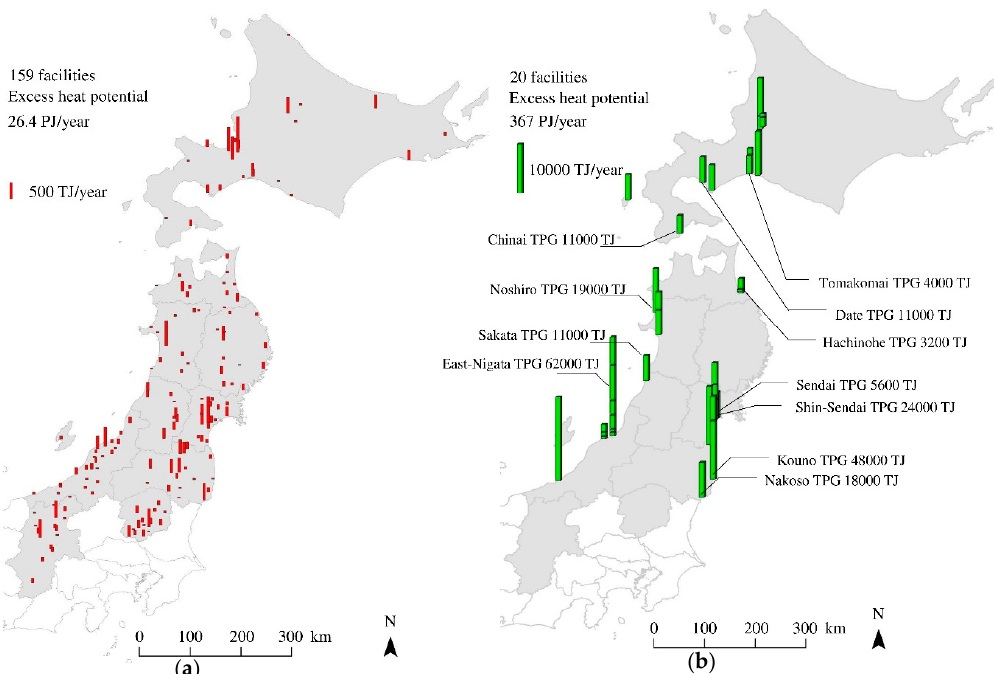
Figure 6. Excess heat potential distribution map. ( a ) Waste incineration plants. ( b ) Thermal power plants.